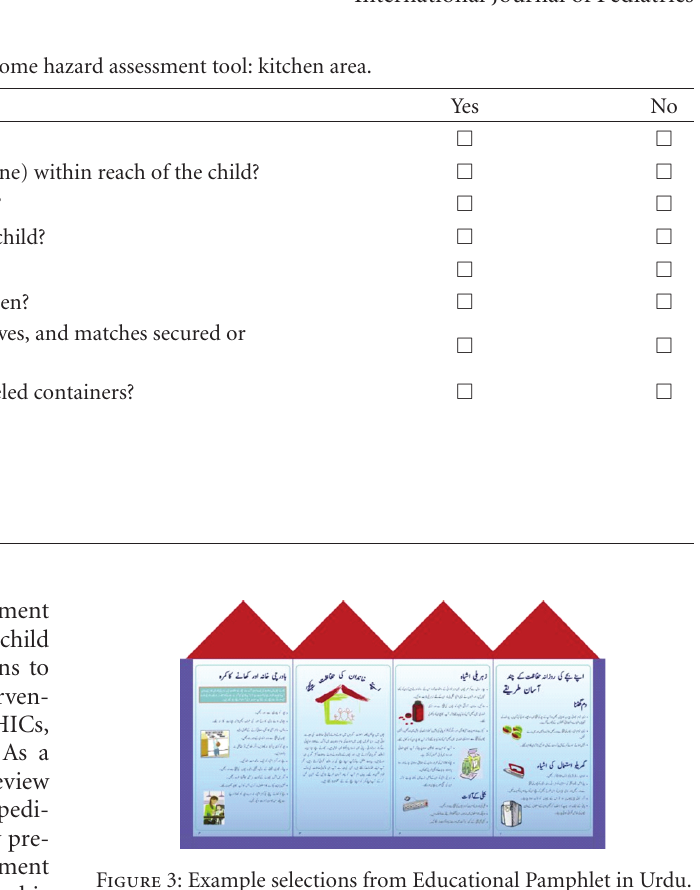
Figure 3: Example selections from Educational Pamphlet in